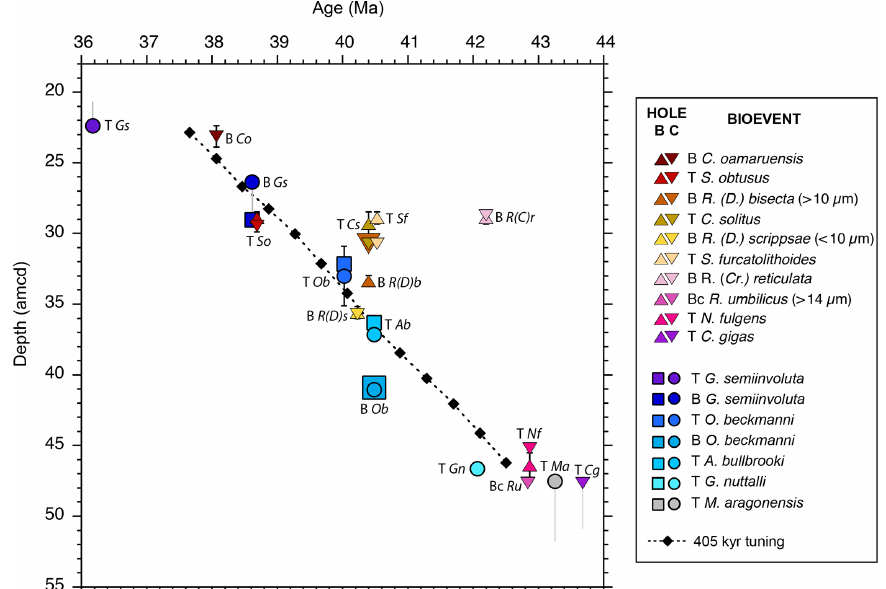
Figure 6. Age–depth plot for ODP Site 865. Only datums falling within the new adjusted metres composite depth (amcd: adjusted metres composite depth) scale are included here. To see all calcareous microfossil datums from the study interval see Fig. S3. Planktic foraminiferal datums are from this study and Pearson and Coxall unpub . (presented in Pearson and Ezard, 2014) (Table 5). Calcareous nannofossil datums are from this study and Bralower and Mutterlose (1995) (Table 6). Depth uncertainties in datums are indicated by vertical lines (black lines: amcd scale; grey line: Top or Bottom depth falls outside of amcd scale and is shown in mb.s.f.) and where not visible are smaller than the symbol. Black diamonds are the tuning tie points to the orbital solution (Table S2). Ages are shown on the Gradstein et al. (2012) timescale. Abbreviations of datums are T, B, or Bc for Top, Base, or Base of common occurrence, respectively, followed by the first letter of the genus and species name.